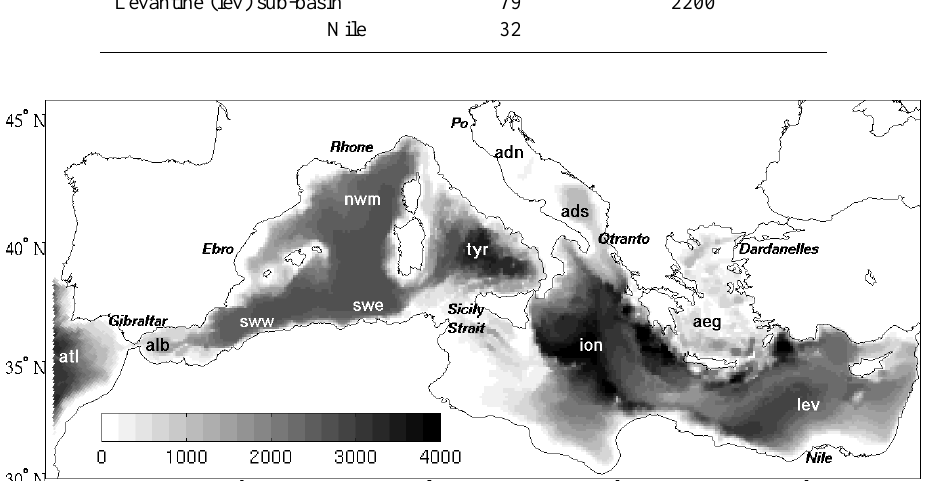
Figure 1. Map of the Mediterranean Sea domain reporting the sub-basins indication (atl, Atlantic buffer zone; alb, Alboran Sea; nwm, north-west Mediterranean; sww, south-west west; swe, south-west east; tyr, Tyrrhenian Sea; ion, Ionian Sea; adn, northern Adriatic Sea; ads, southern Adriatic Sea; aeg, Aegean Sea; lev, Levantine sub-basin), the location of principal rivers and